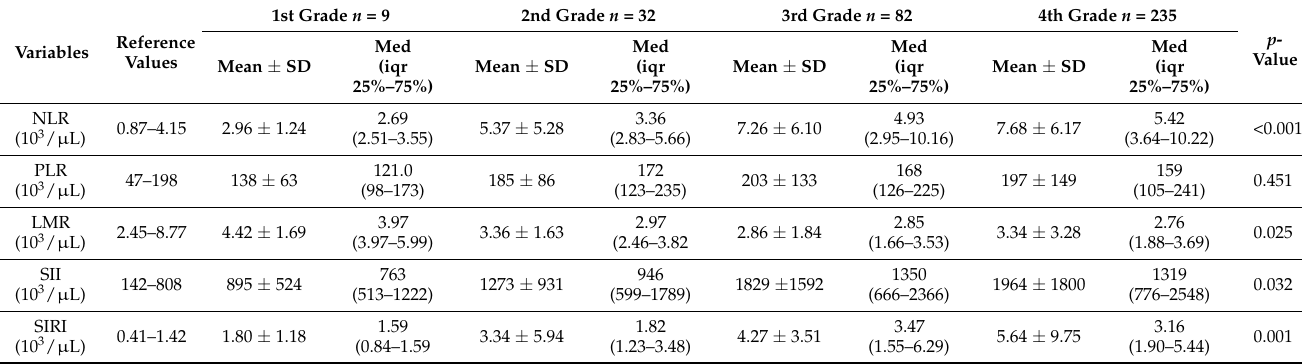
Table 3. Blood cell count-derived inflammation indices ( n = 358).